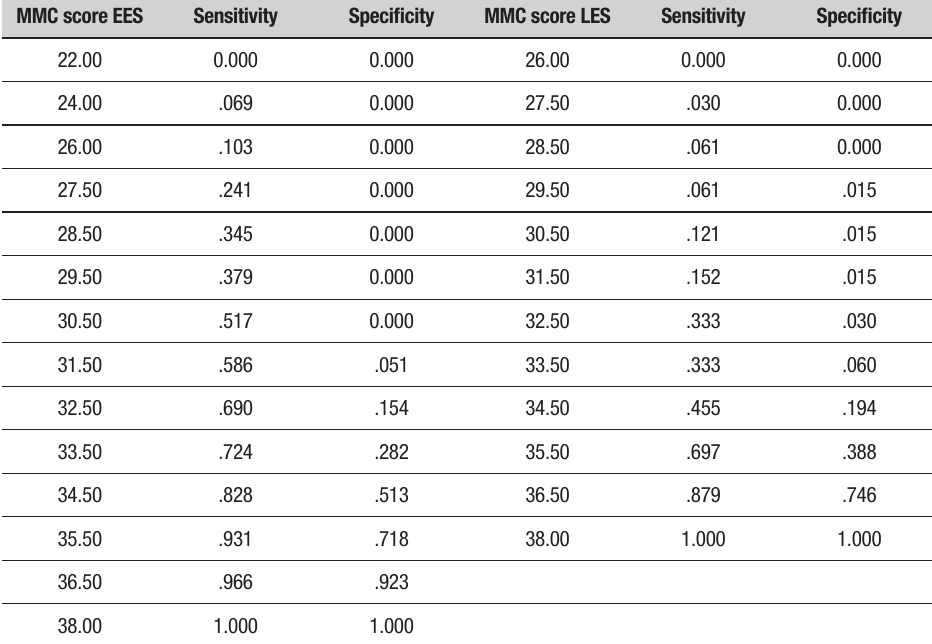
Table 3. Cut-off scores for the two groups on the MMC according to sensitivity and specificity. MMC score EES Sensitivity